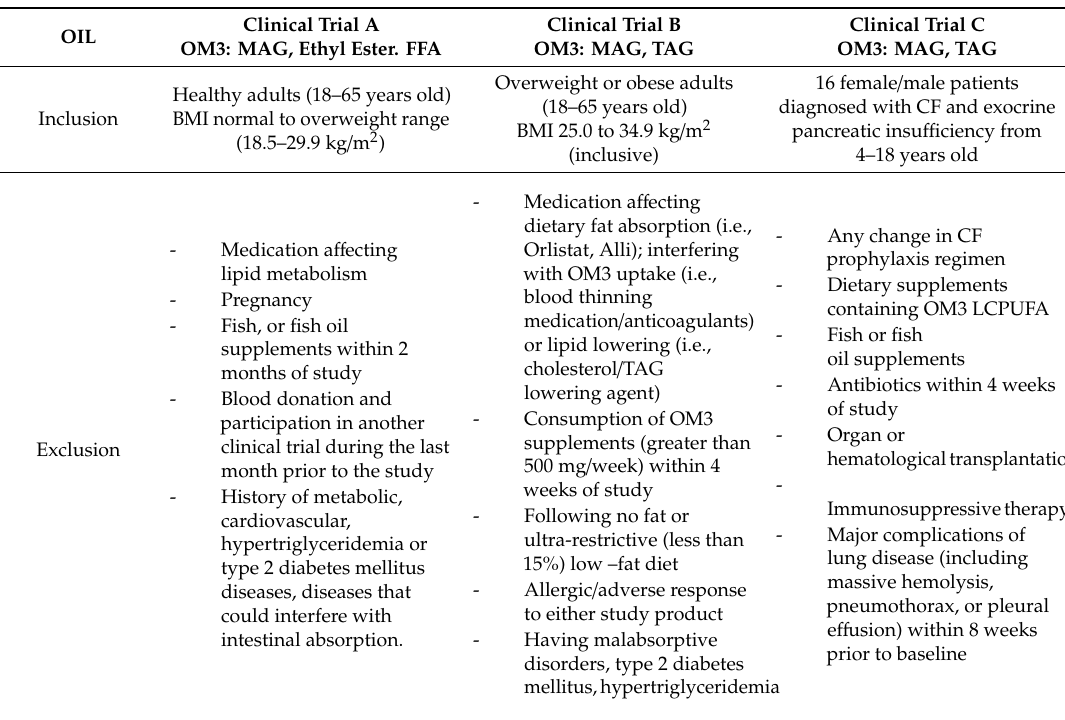
Table 2. Clinical trials inclusion and exclusion